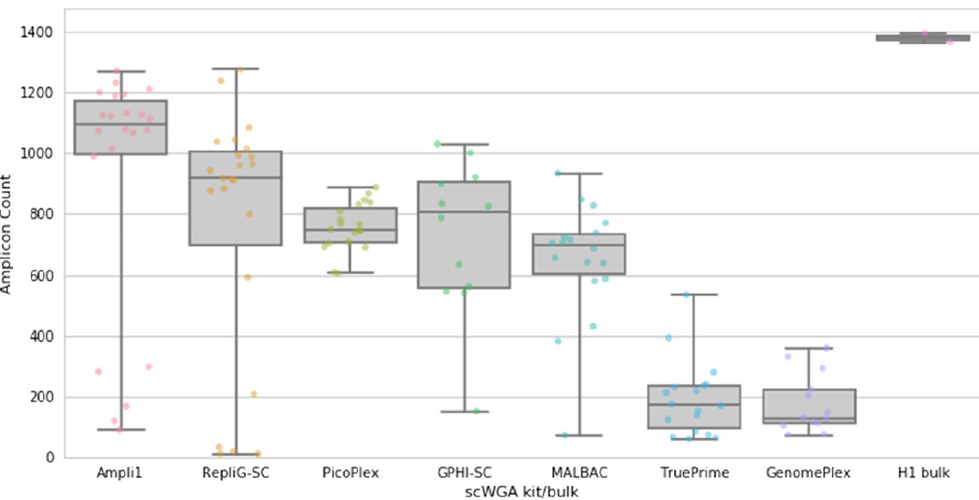
Figure 1. Amplicon coverage per single cell kit of only X chromosome “TTAA” free amplicons. Mapped amplicons were counted per each single cell. Data represents only MseI restriction site free amplicons (“TTAA”) in the X chromosome (see Supplementary Dataset S3), to follow the internal bias of the Ampli1 against these amplicons (see Supplementary Fig. 2). Each dot represents a single cell, except for the right column, where each dot represents a cell bulk duplicate, originated from the same cell line (H1). Each column is the collection of all single cells per scWGA kit (except for the H1 bulk column). The theoretical maximum is 1912 amplicons that follow the X chromosome, TTAA free criteria. However, 327 amplicons failed to amplify in all samples, making the practical maximum number of working amplicons for this analysis